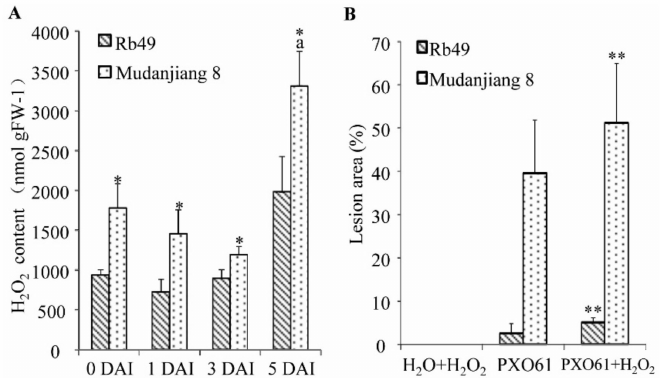
Figure 5. Small amounts of H 2 O 2 accumulation in Xa3 / Xa26- mediated resistance and the increased rice susceptibility to Xoo by in vitro H 2 O 2 application. ( A ) H 2 O 2 content of Rb49 and Mudanjiang 8 leaves infected by Xoo strain PXO61. Data represent the mean (total of three leaves from three plants) + standard deviation (SD). Letter “a” indicates statistically significant di ff erences between 0 day and other time in the same rice plant ( p < 0.01). Double asterisks (** p < 0.01) and single asterisk (* p < 0.05) indicate statistically significant di ff erences between Rb49 and Mudanjiang 8 at same inoculation time point. ( B ) E ff ect of in vitro H 2 O 2 spraying on lesion area of Rb49 and Mudanjiang 8 leaves inoculated by H 2 O and inoculated by Xoo strain PXO61. Double asterisks (**) indicate significant di ff erences ( p < 0.01) between sprayed H 2 O 2 plants and unsprayed H 2 O 2 plants after inoculation with PXO61. Each bar represents mean (11–24 leaves from three plants) +